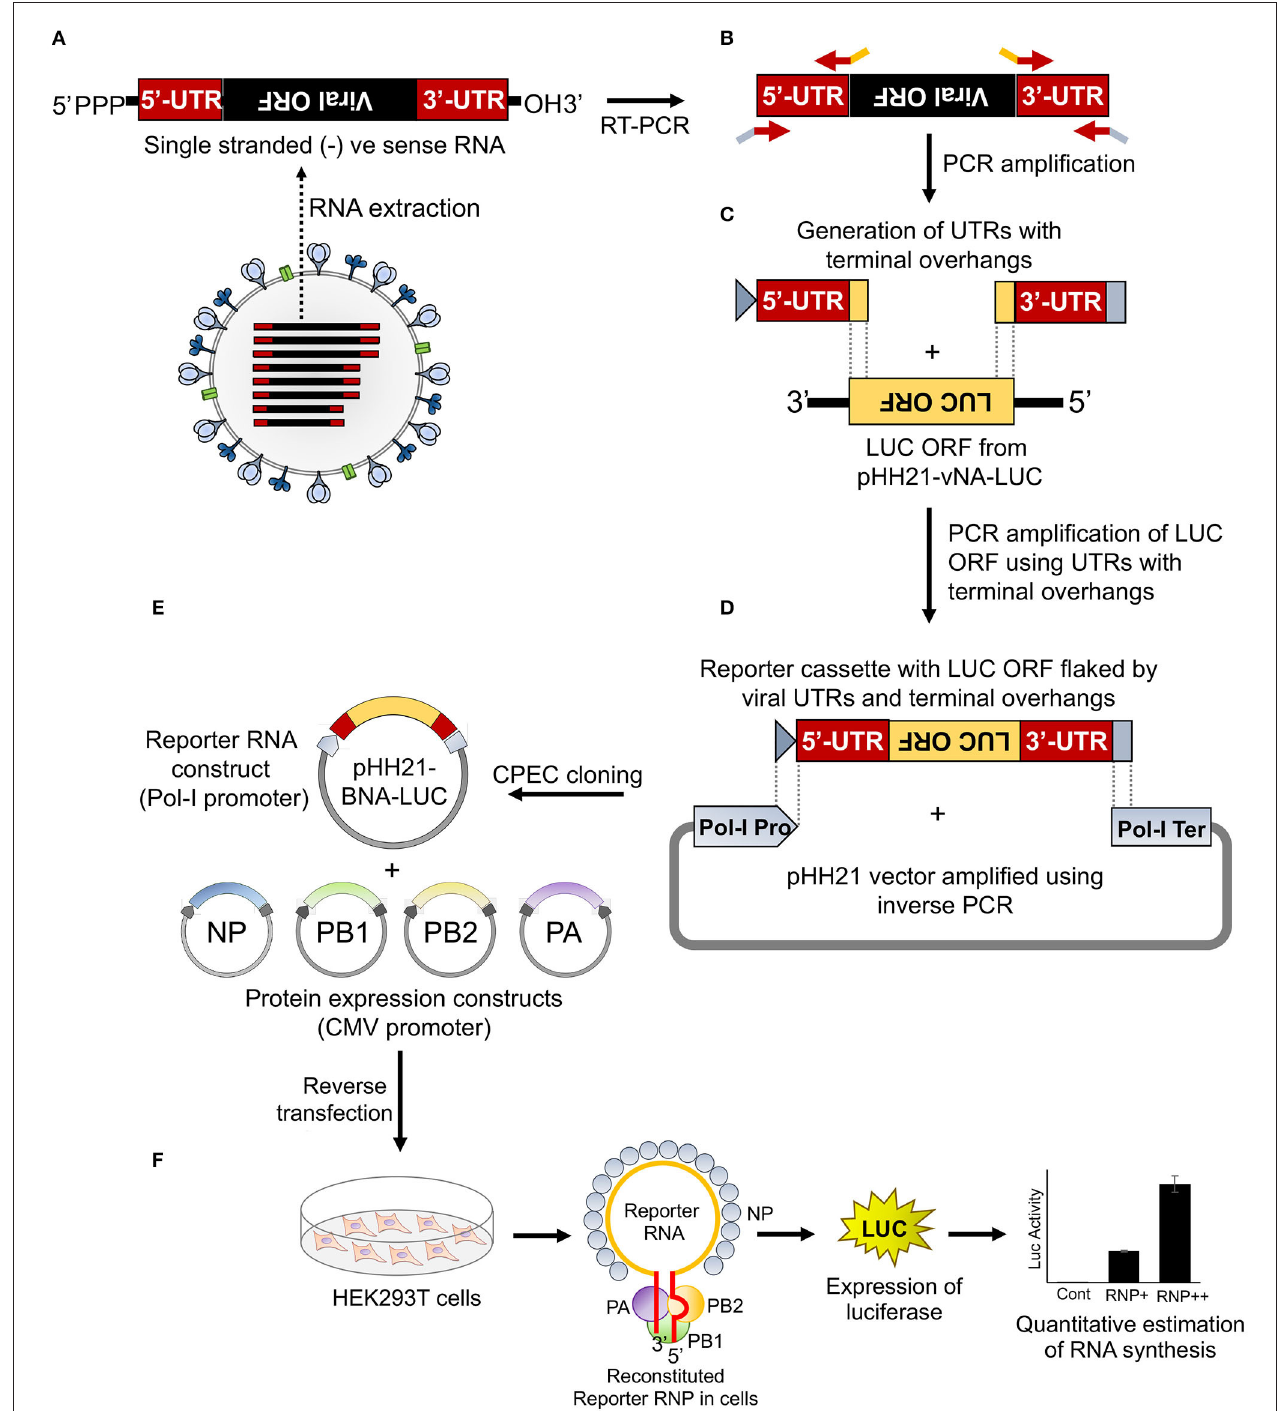
FIGURE 1 | An overview of the cloning strategy of influenza B reporter plasmid and reporter assay. (A) Total RNA was isolated from amplified stocks of influenza B/Brisbane/60/2008 virus. (B) Total RNA was converted to cDNA by performing reverse transcription polymerase chain reaction (RT-PCR) and the 5 ′ and 3 ′ untranslated regions (UTRs) were amplified using specific primers containing overhangs. (C) The double-stranded 5 ′ and 3 ′ UTRs containing overlapping regions were used as primers to amplify the luciferase open reading frame (ORF). (D) The resulting PCR product was used as an insert for circular polymerase extension cloning (CPEC) assembly with the PCR amplified vector fragment. (E,F) The generated reporter and other protein expressing plasmids, upon co-transfection in human embryonic kidney 293T (HEK 293T) cells, reconstitute luciferase RNPs that express the luciferase enzyme under the control of the viral promoter. The quantification of the luciferase signal gives the measure of viral polymerase